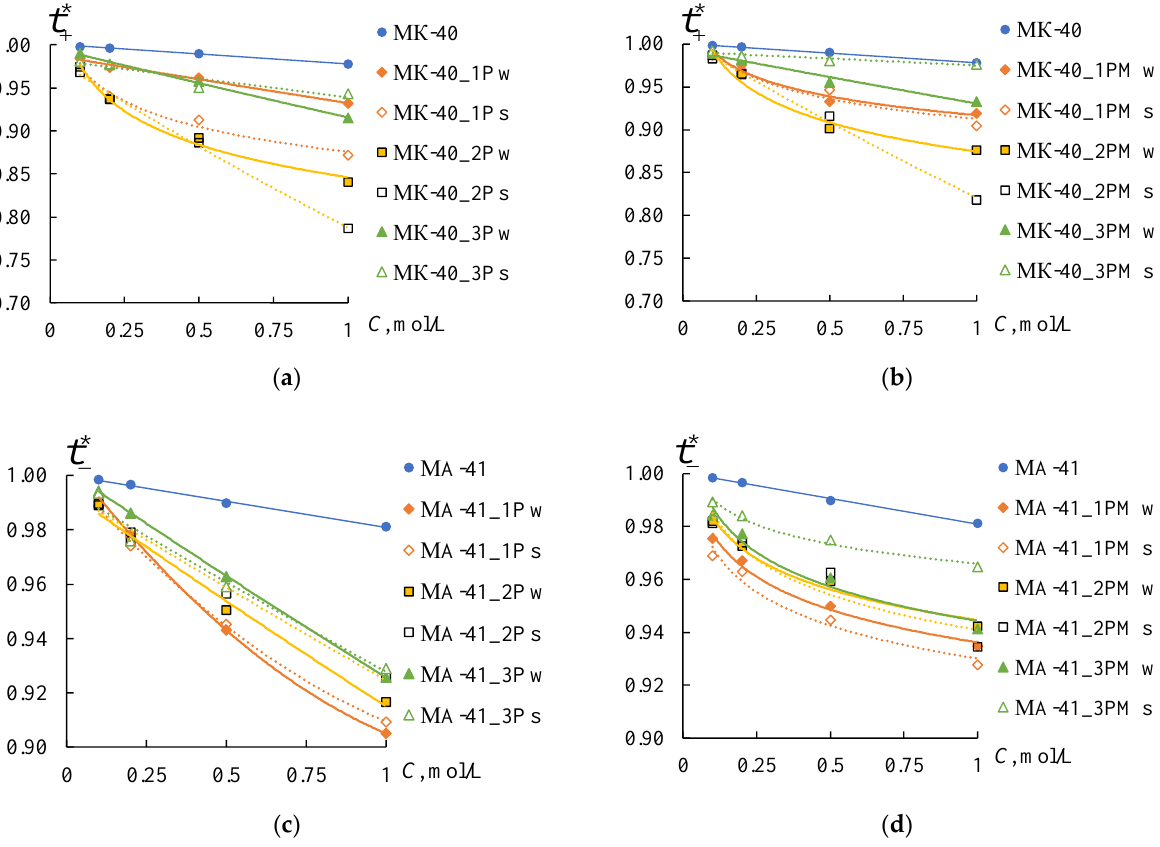
Figure 13. The concentration dependencies of the counter-ion transport number in the MK-40 CEMs ( a , b ) and MA-41 AEMs ( c , d ), where ( a , c ) are profiled membranes, ( b , d ) are bilayer profiled membranes